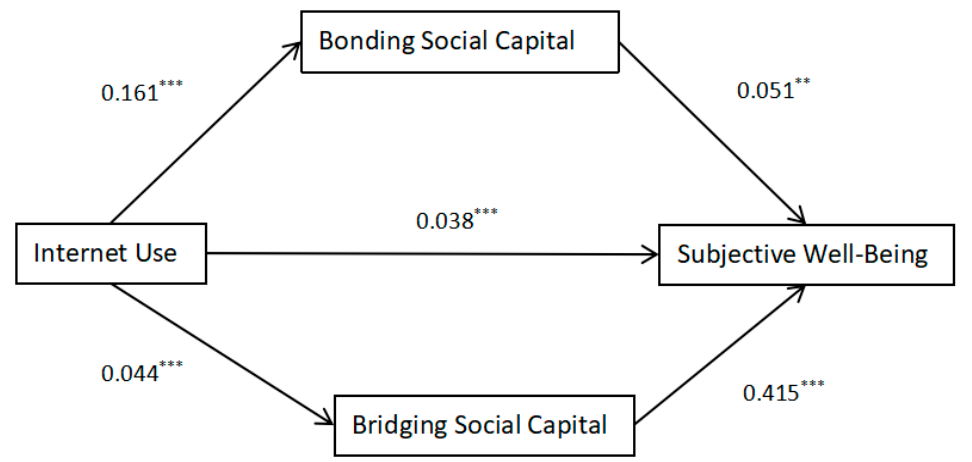
Figure 4. Path analysis of the influence of Internet use on the subjective well-being of the elderly. Note: *** p < 0.01, ** p < 0.05. The coefficients in the abovementioned model are standardized path coefficients.